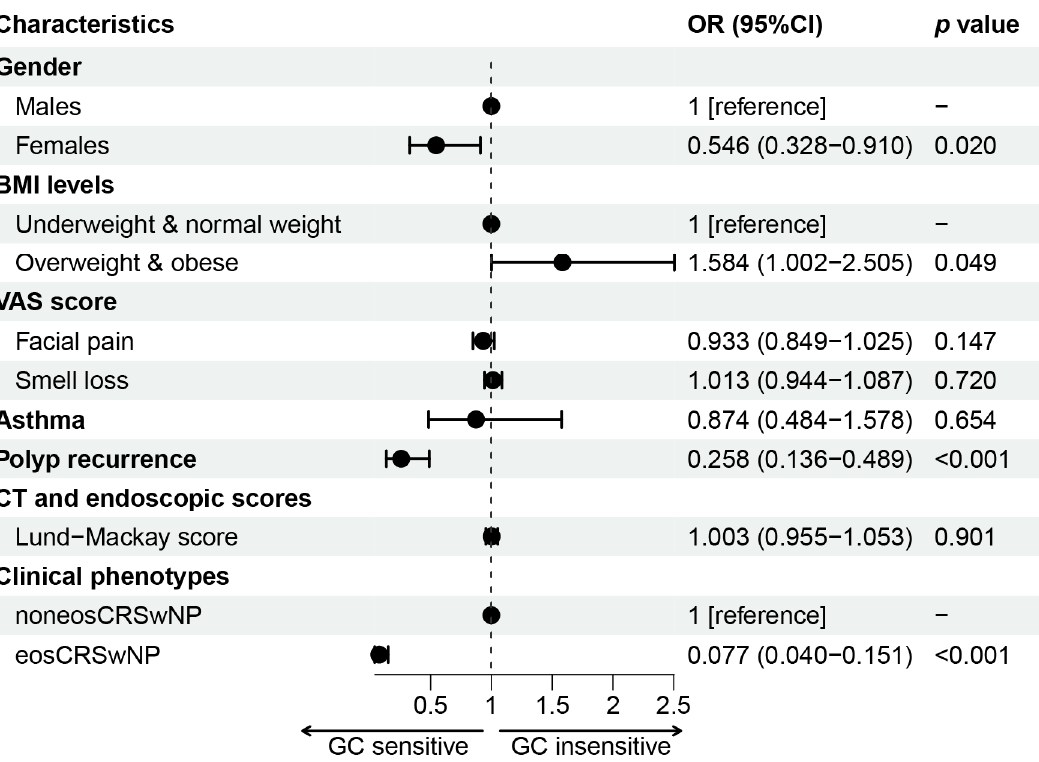
Figure 2. Logistic regression of glucocorticoid (GC) insensitivity. OR: odds ratio; CI: confidence interval; BMI: body mass index; VAS: visual analog scale; NP: nasal polyp; CT: computed tomography.